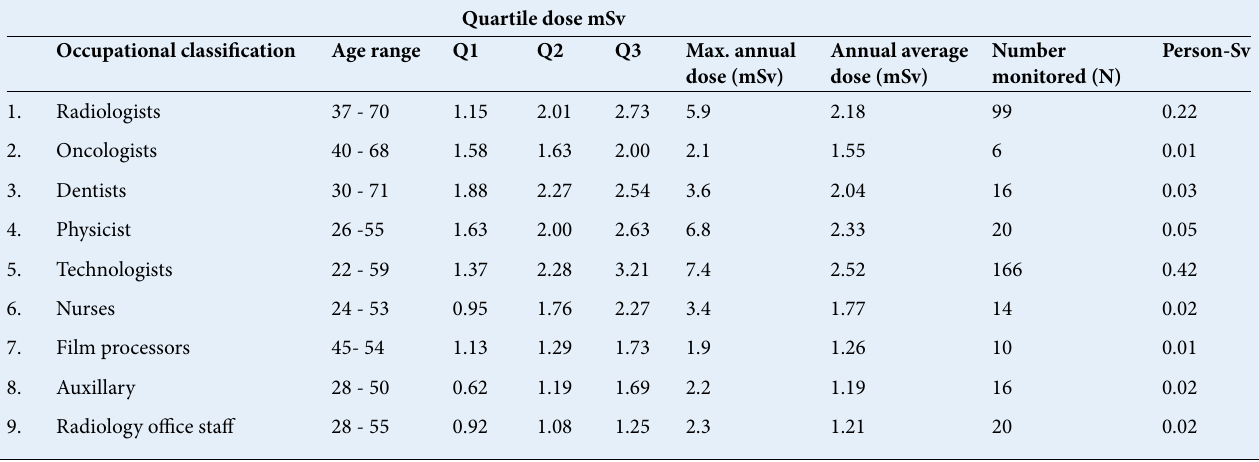
Table I. Annual radiation exposure dose measured with TLDs worn by occupationally exposed personnel in the medical sector Quartile dose